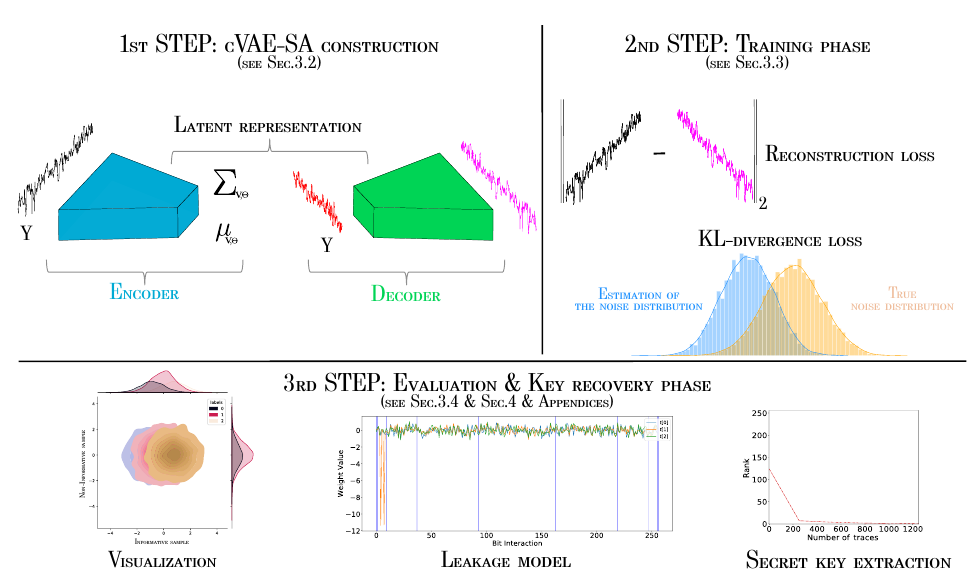
Figure 1: Overview of this